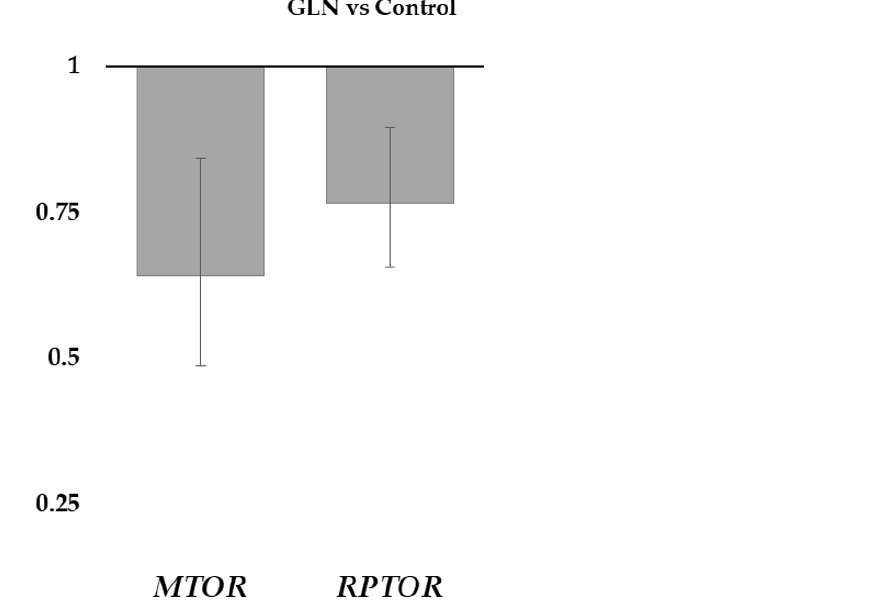
Figure 1. Fold-change (FC) ratios of MTOR and RPTOR genes with significant differences between maternal treatments within normal birth-weight (BIW) newborns. FC values <1 indicate higher expression in the first group. The error lines indicate the standard errors. GLN: group treated with